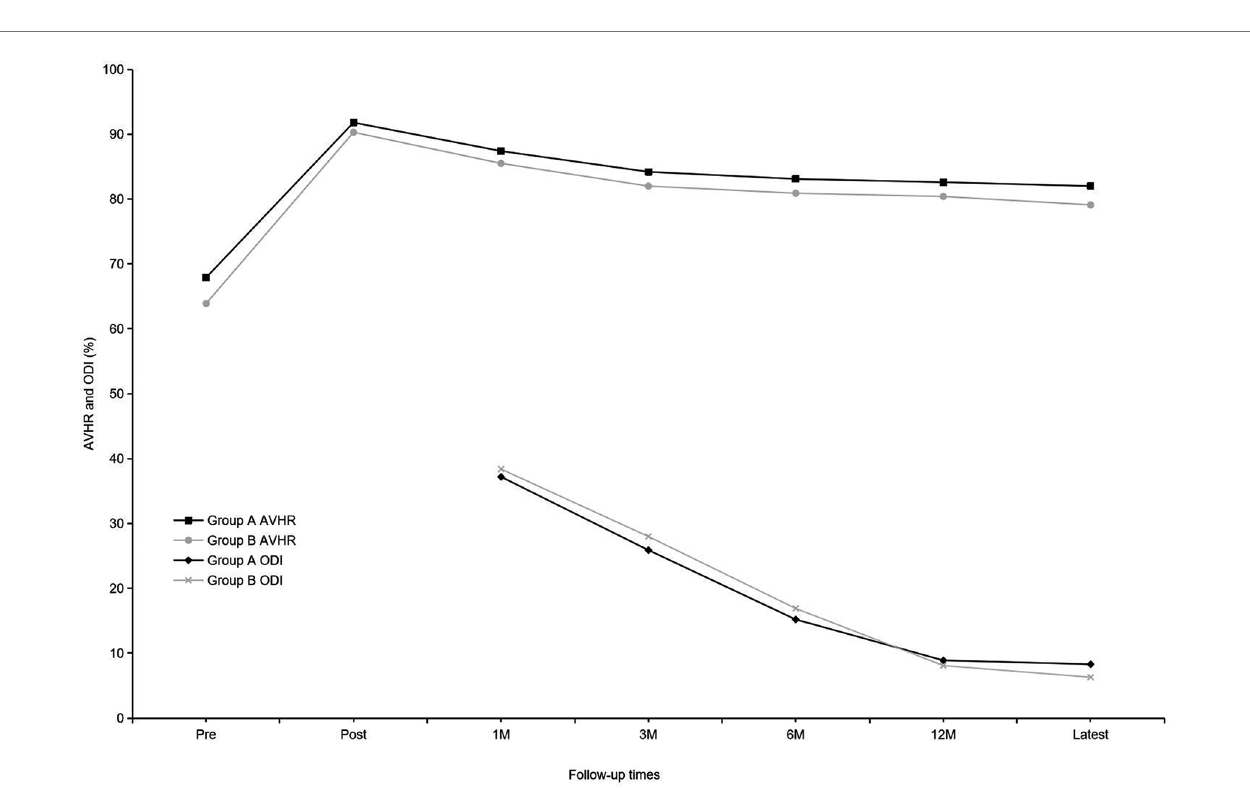
FIGURE 3 | Mean anterior vertebral body-to-height ratio and mean Oswestry Disability Index of the two groups at each time point.